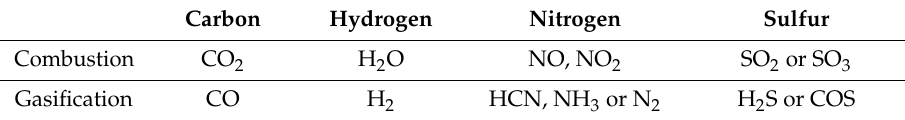
Table 1. Comparison between the combustion and gasification products